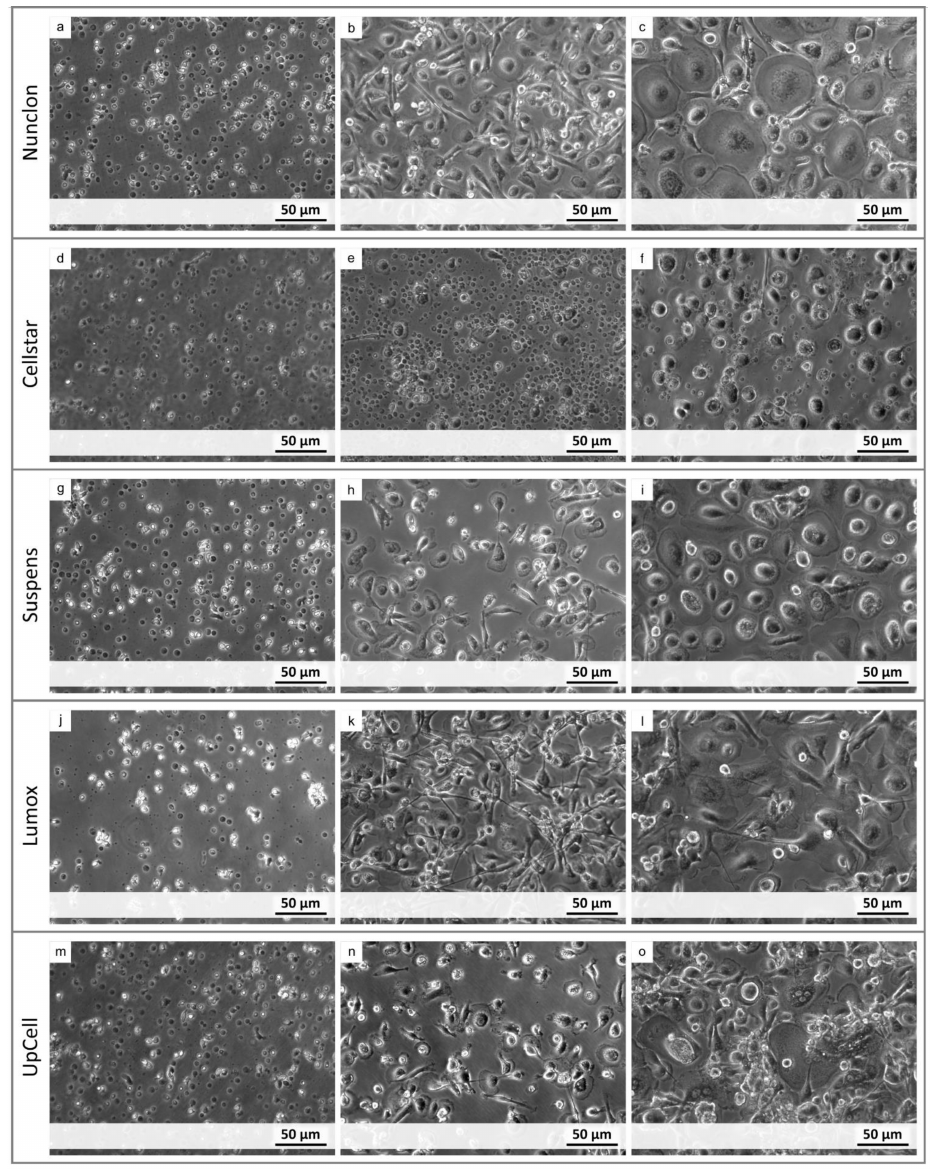
Figure 1. Light microscopy images of monocyte-derived osteoclasts after 1 day (left column), 4 days (middle column), and 7 days (right column) of cultivation on different cultivation surfaces (Nunclon, Cellstar, Suspens, Lumox, UpCell) ( a – o